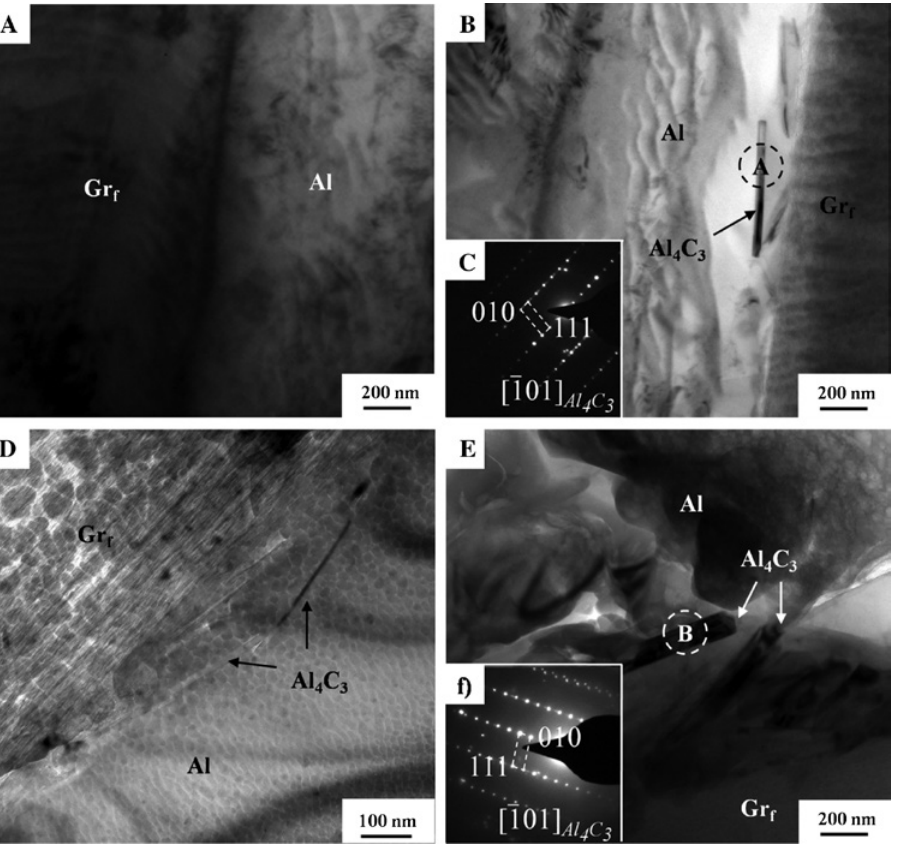
/Al composites: (A) no treatment, (B) 550 ° C/4 h, f